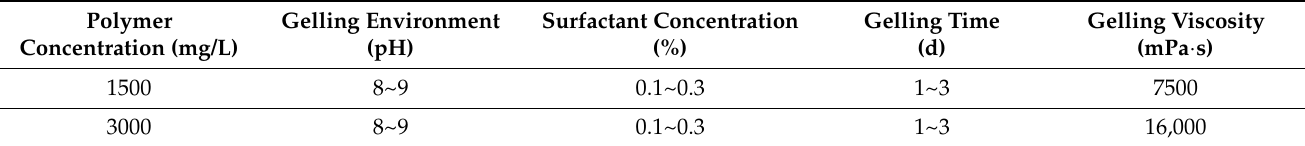
Table 4. Multi-complex type and ternary system compatibility system